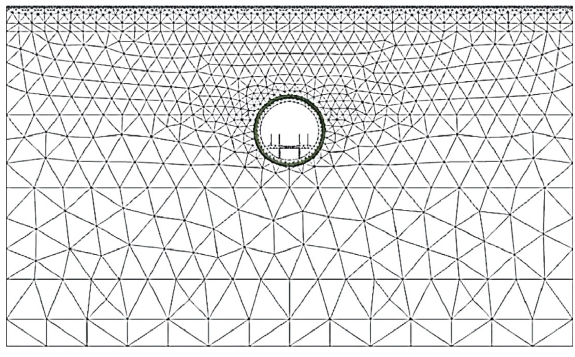
Figure 5: FEM model of the tunnel and